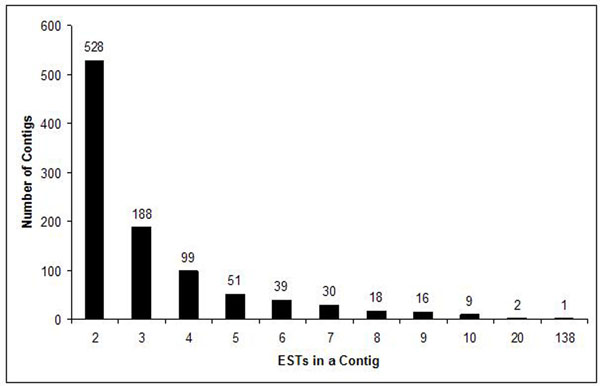
Distribution of 4929 ESTs in 1053 contigs